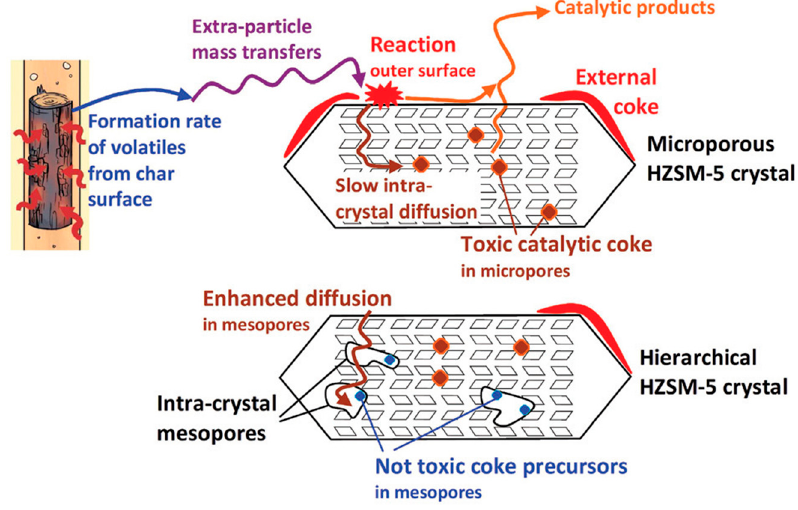
Figure 9. Schematic diagram of the mechanism of coke formation during the catalytic pyrolysis of biomass. (Adapted from [128]. Copyright 2017 Royal Society of Chemistry).